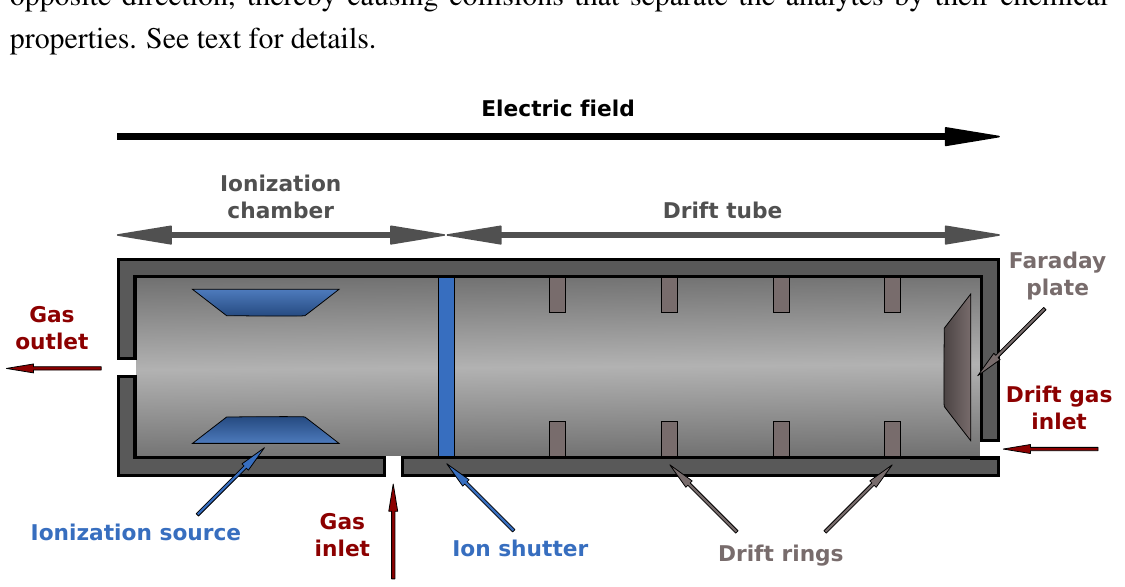
Figure 3. Schematic view of an IMS device. After ionization the analytes